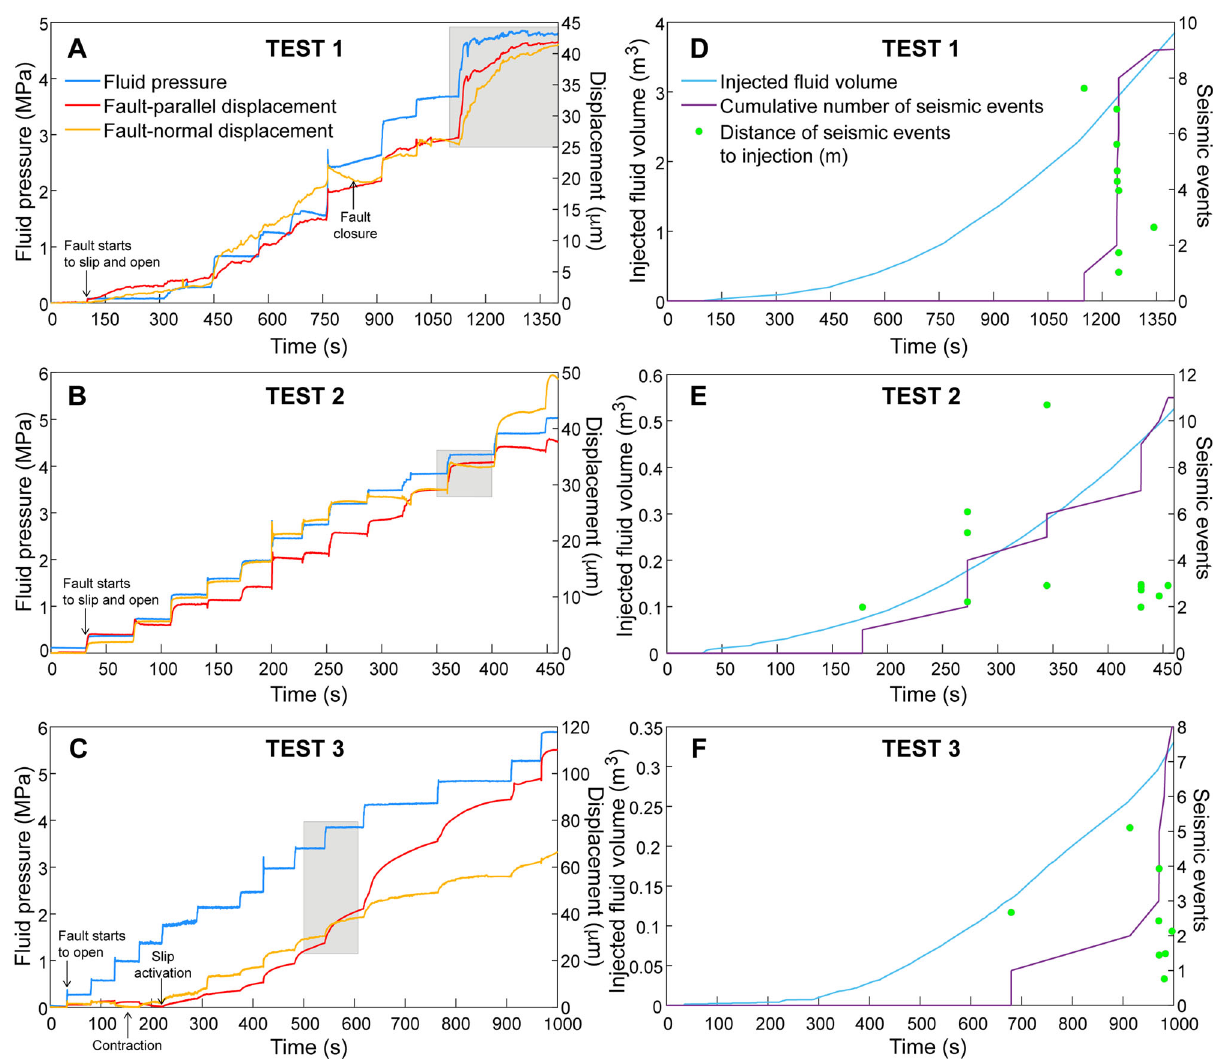
Fig. 2 Experimental data collected during three fl uid injection tests (Tests 1, 2 and 3) within the fault zone. A – C Fluid pressure (blue), fault-normal (opening in orange) and fault-parallel (slip in red) displacements; ( D – F ) Injected fl uid volume (cyan line and left axis), cumulative number of seismic events (purple line and right axis), and distance (m) of seismic events relative to injection (green dots and right axis). The gray boxes in the panels ( A , B , and C ) represent the data sequences used for the